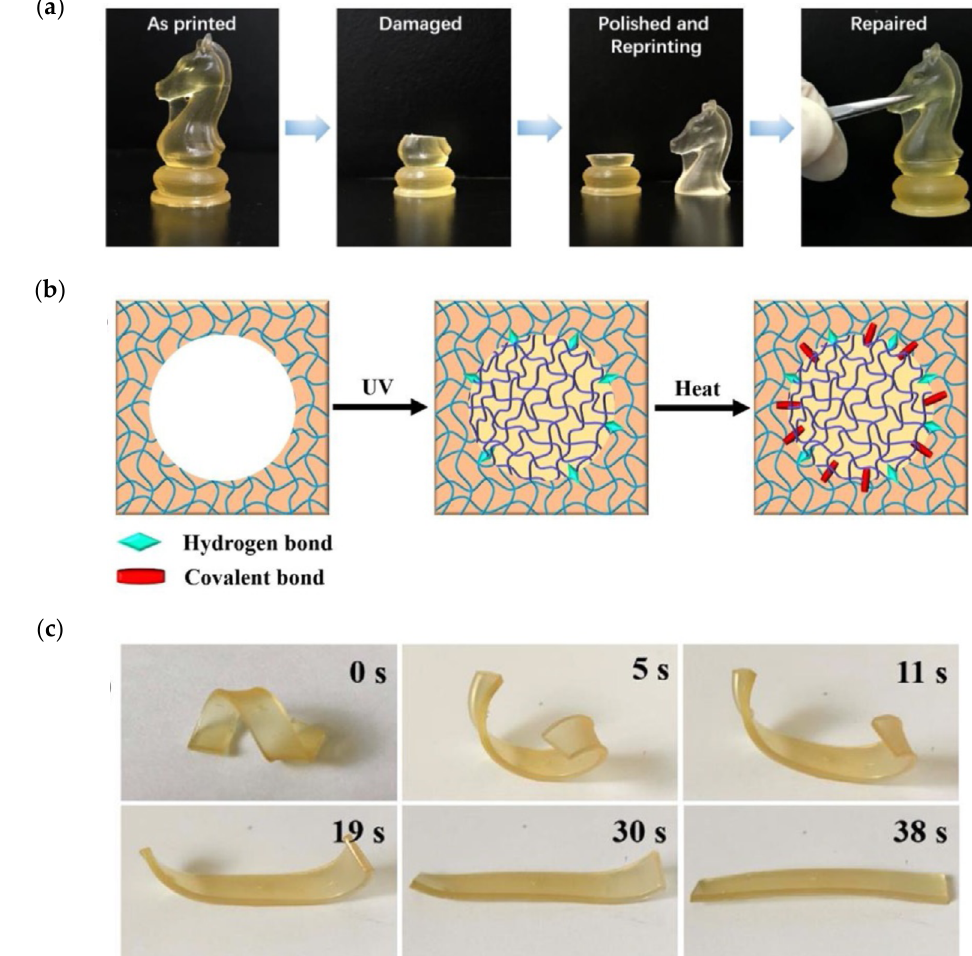
Figure 13. ( a ) Visual demonstration of the repairability and its mechanism ( b , c ) of the shape memory ability, of the 3D printed thermosets of Lu et al. [70]. Reproduced from [70] with permission from Wiley.